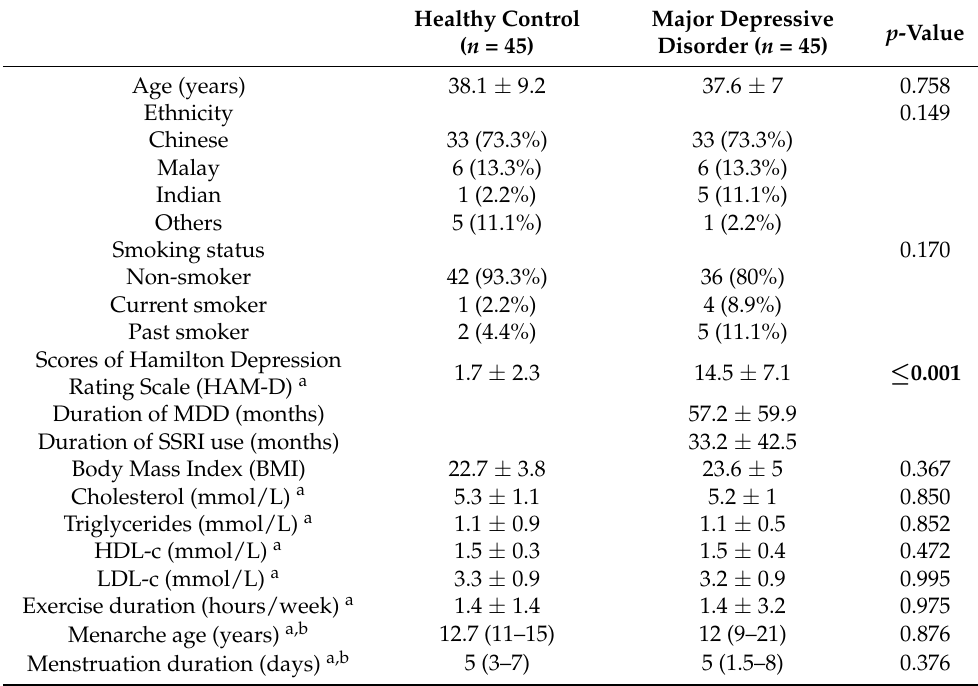
Table 1. Characteristics of patients with MDD receiving SSRIs and healthy